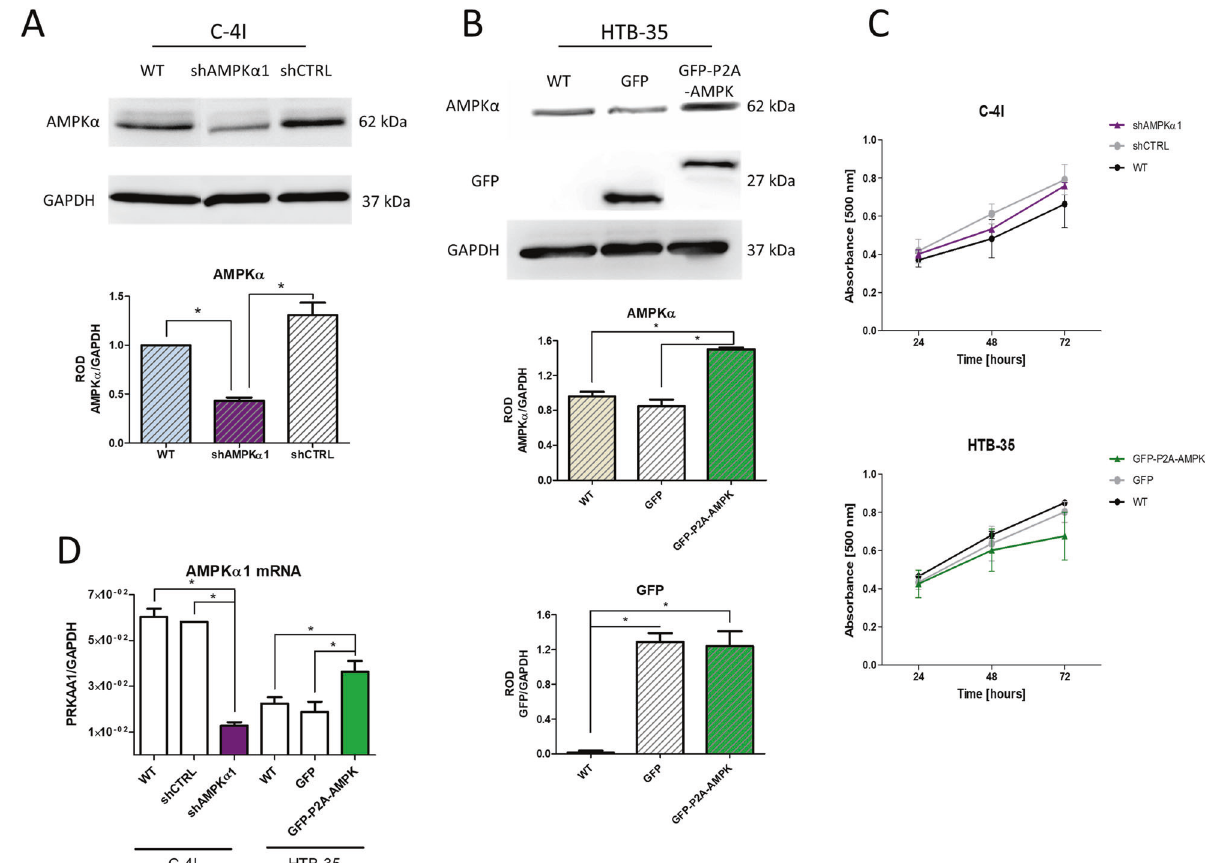
Fig. 3 Generation of genetically modi fi ed CC lines with increased and decreased AMPK α expression. The evaluation of AMPK α 1 catalytic subunit knockdown in C-4I cells ( A ) and GFP and AMPK α protein expression in selected and sorted HTB-35 lines ( B ). Membrane pictures show representative results of three independent assessments. Quantitative results presented on bar graphs are based on densitometry of the analyzed gene to the reference gene. Data are presented as mean ± SEM ( n = 3). Asterisks indicate statistically signi fi cant differences ( p < 0.05). Determination of cell proliferation of modi fi ed C-4I and HTB-35 lines by MTS ( C ). The points on the graph show the mean absorbance of three replicates ± SEM. D Transcript level of AMPK α 1 catalytic subunit in 6 lines of the developed cellular model. The graphs represent the mean of three independent analyses of the relative expression of the gene to the reference gene GAPDH ± SEM. Asterisks indicate statistically signi fi cant differences ( p <